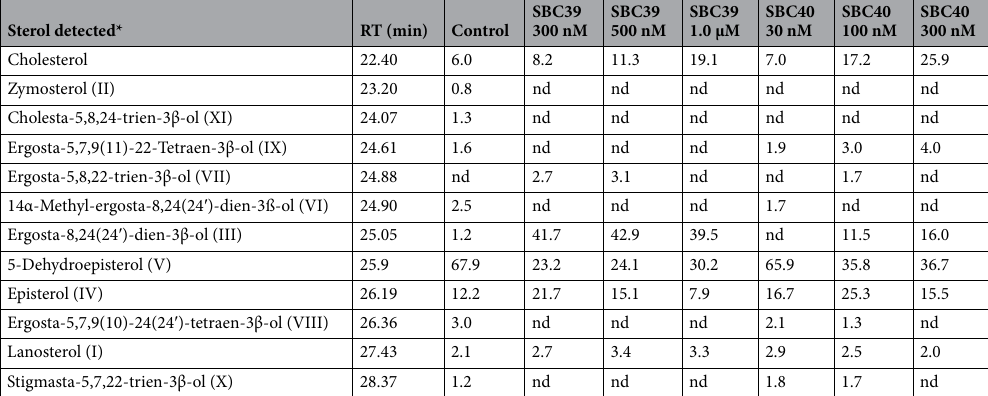
Table 1. Composition of free sterols from SBC analogs-treated and non-treated L. amazonensis promastigotes. The numbers found in the columns for control and treated parasites represent the percentage of total sterols. RT retention time, nd no detected; Sterols structure: see Fig. 13.